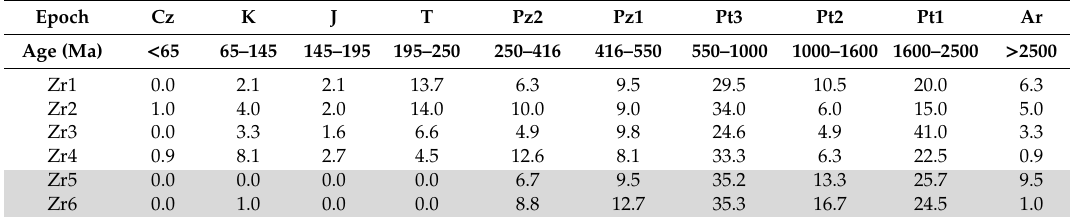
Table 3. Composition of zircon ages in core RGK15 (%).